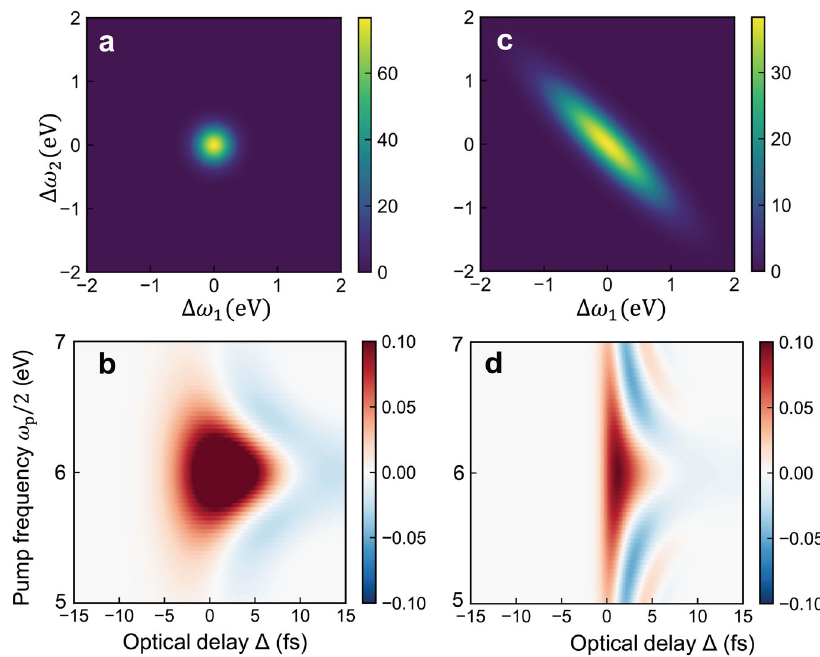
Fig. 5 2D photon coincidence counting signal. P ab ( Δ , ω p ) [Eq. (7)] for the model system of Fig. 2b. The pump frequency ω p creating the entangled photon pair and the optical delay between two arms are varied. We approximate a sinc-shape of the two-photon wavefunction by a Gaussian for simpli fi ed h (cid:3) (cid:4) 2 = ð 16 σ 2 Þ frequency integration: Φ ð ω 1 ; ω 2 Þ ¼ ð 2 πσ þ σ (cid:3) Þ (cid:3) 1 = 2 exp (cid:3) ω 1 þ ω 2 (cid:3) ω p . a Two-photon wavefunction of unentangled þ photons with σ + = 0.1 eV, σ − = 0.2 eV. b The Hong-Ou-Mandel (HOM) spectrum using the two-photon state in ( a ). c Two-photon wavefunction of highly entangled twin photons with energy anti-correlation. Here σ + = 0.1 eV, σ − = 0.8 eV. d The HOM spectrum obtained using the twin-photon state in ( c ). The resolution is clearly enhanced by the entangled photon